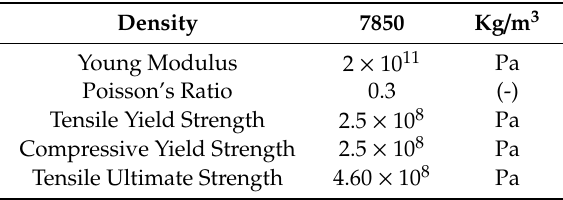
Table 1. Properties of the utilized structural steel